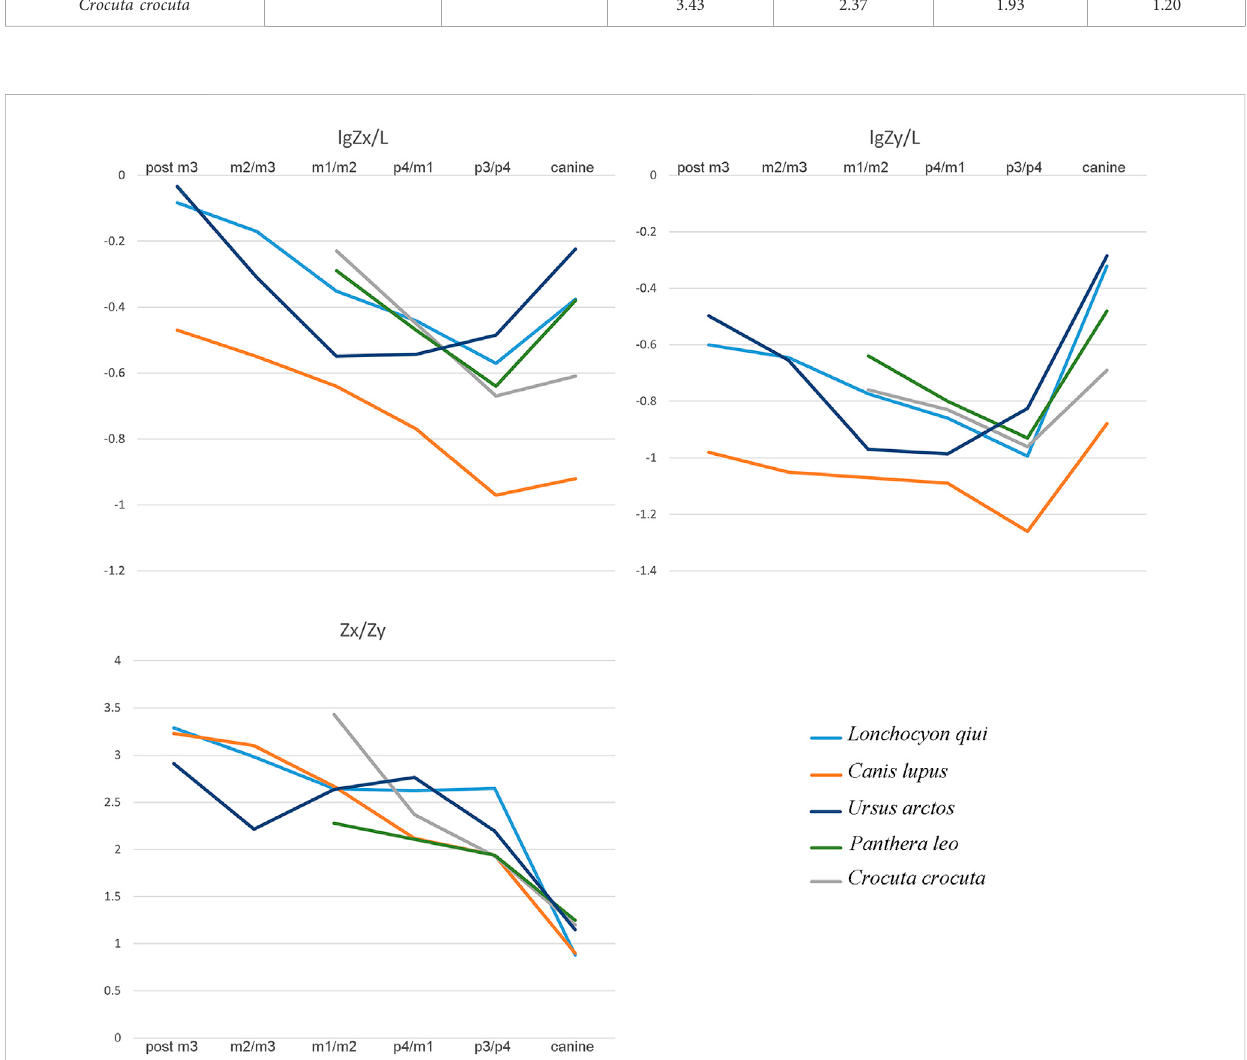
FIGURE 5 Comparison of mandibular force pro fi les among L. qiui , C. lupus , U. arctos , P. leo, and C. crocuta .